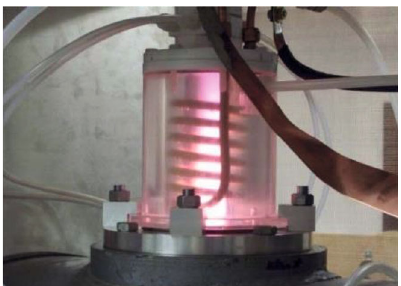
Figure 8: IPG6-B in the University of Stuttgart